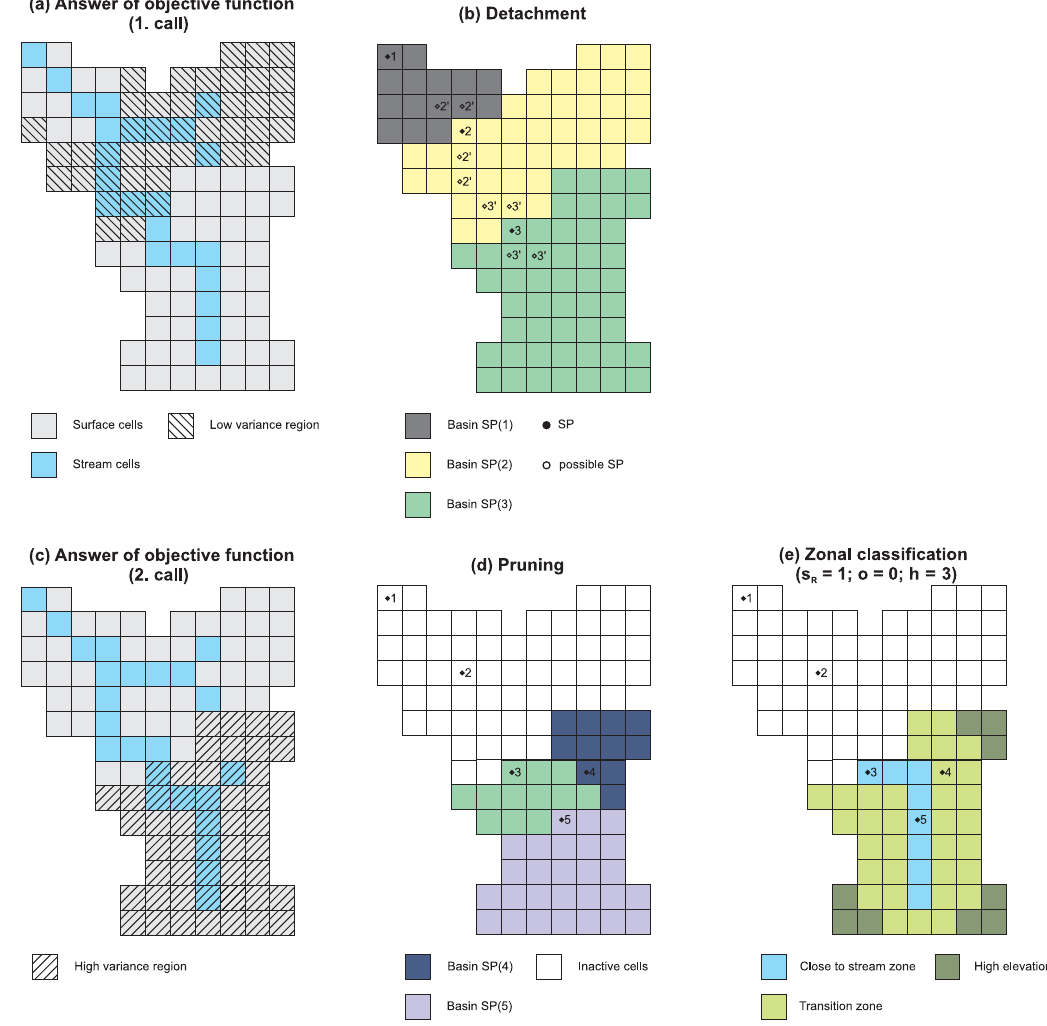
Figure 7. (a, c) Answers of the objective function; result of (b) detachment, (d) pruning, and (e) zonal classification in the synthetic catch-